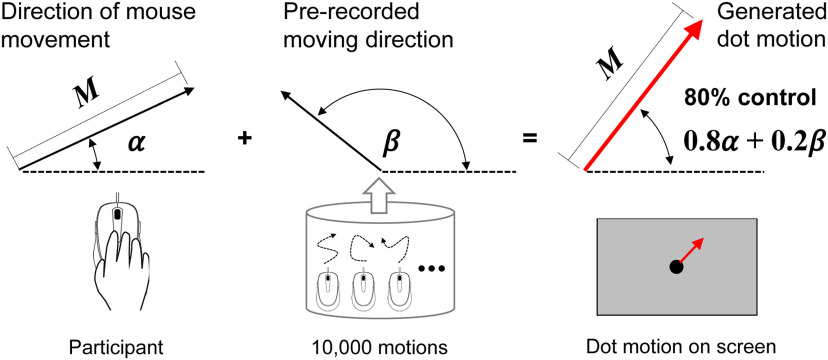
An example of a motion combination algorithm with 80% control. The direction of the visual stimulus (dot) on the screen (red arrow) was generated between the direction of mouse movement (α, in the left panel) and the direction of a prerecorded motion (β, in the middle panel), with an 80/20 ratio at each moment segment (60 Hz). Each direction is represented by the deviation from the right horizontal direction (indicated by dashed lines). The magnitude (M) of the dot movement was equalized to the size of the mouse movement.